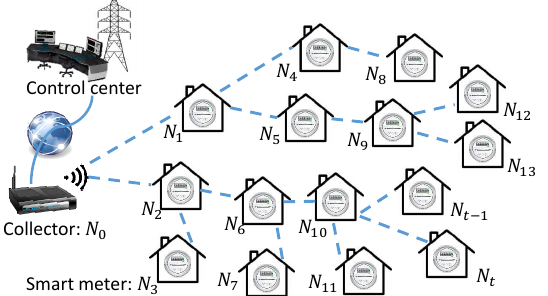
Figure 1. An example of in-network aggregation in NAN. e ffi ciently route the meter data to the collector [14, 21,